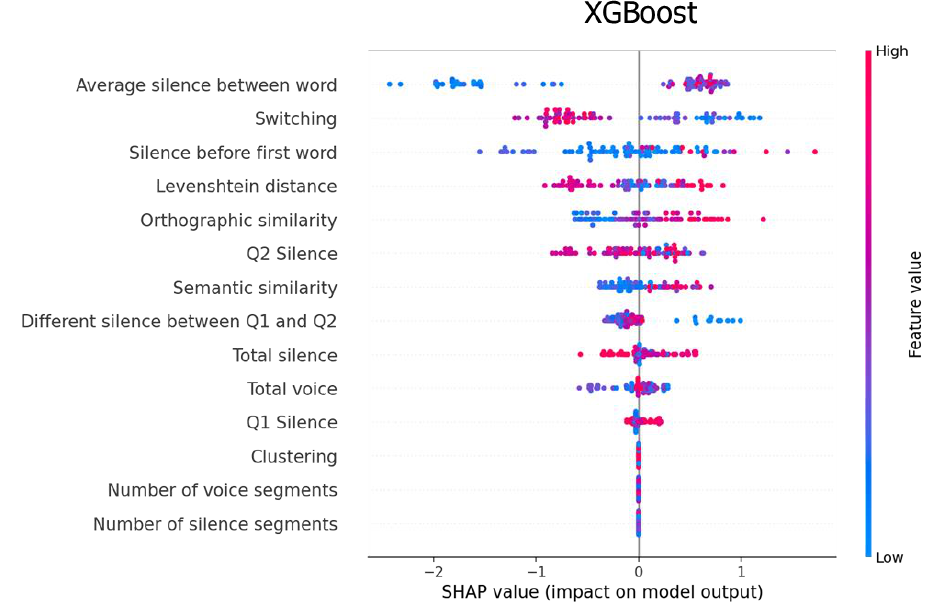
Figure 6 . Feature importance explained by the SHAP value for the XGBoost classifier. Figure 6. Feature importance explained by the SHAP value for the XGBoost